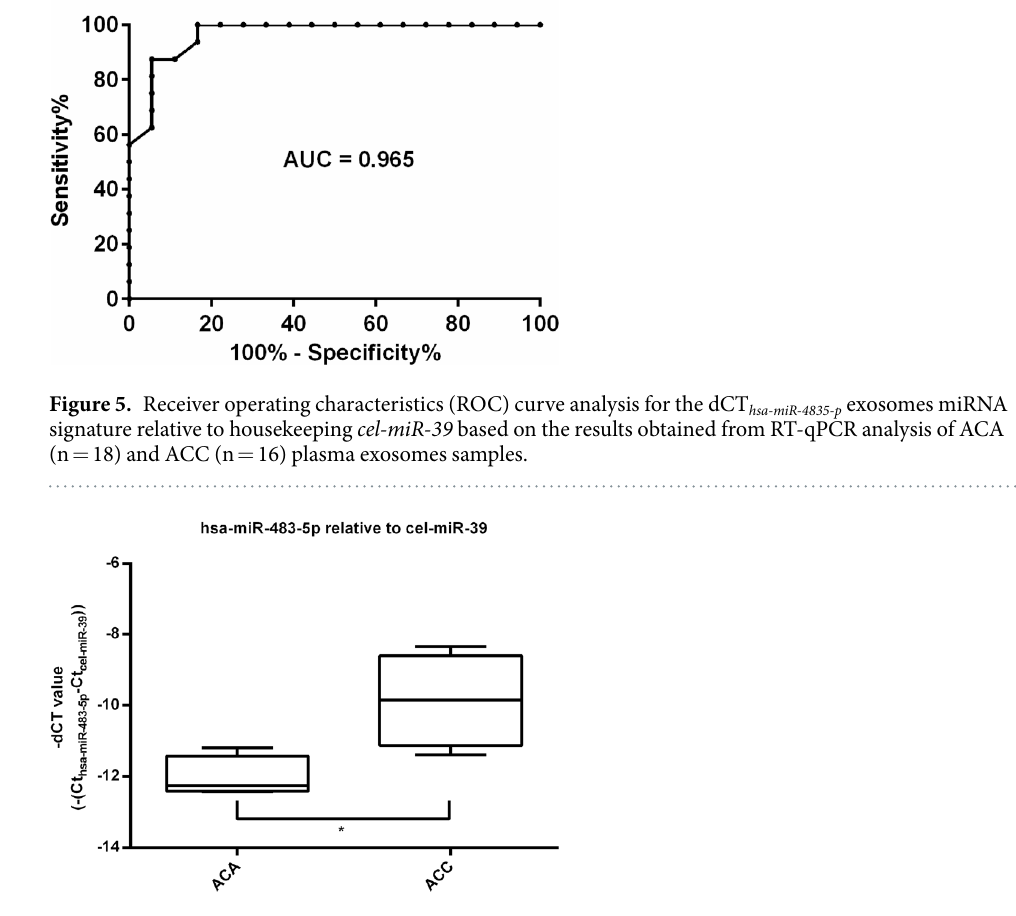
Figure 6. Results of ultracentrifugation with RT-qPCR of hsa-miR-483-5p normalized to the spike-in control cel-miR-39 . Results are represented by – dCT (cycle threshold) (mean ± s.d., * p < 0.05; unpaired t-test; n = 4 ACA, n = 4